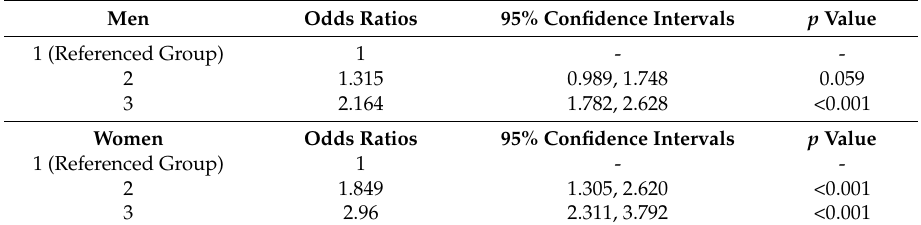
Table 2. Multivariable logistic regression analyses on the association between the three groups of AIP and HUA a